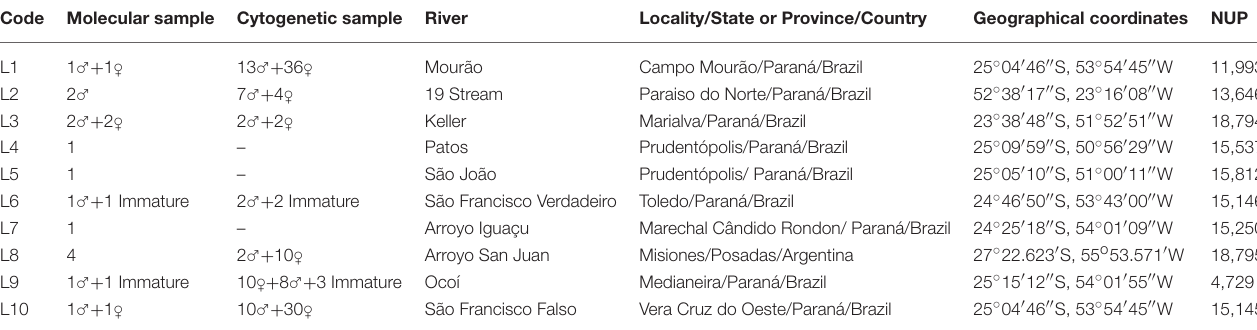
TABLE 1 | Details of the Ancistrus populations and specimens sampled in the study area of the upper Paraná basin. Code Molecular sample Cytogenetic sample River Locality/State or